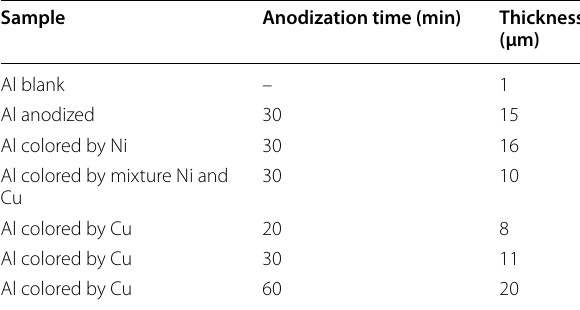
Table 5 Measurements of thin film thickness after electrolytic coloring of Al samples